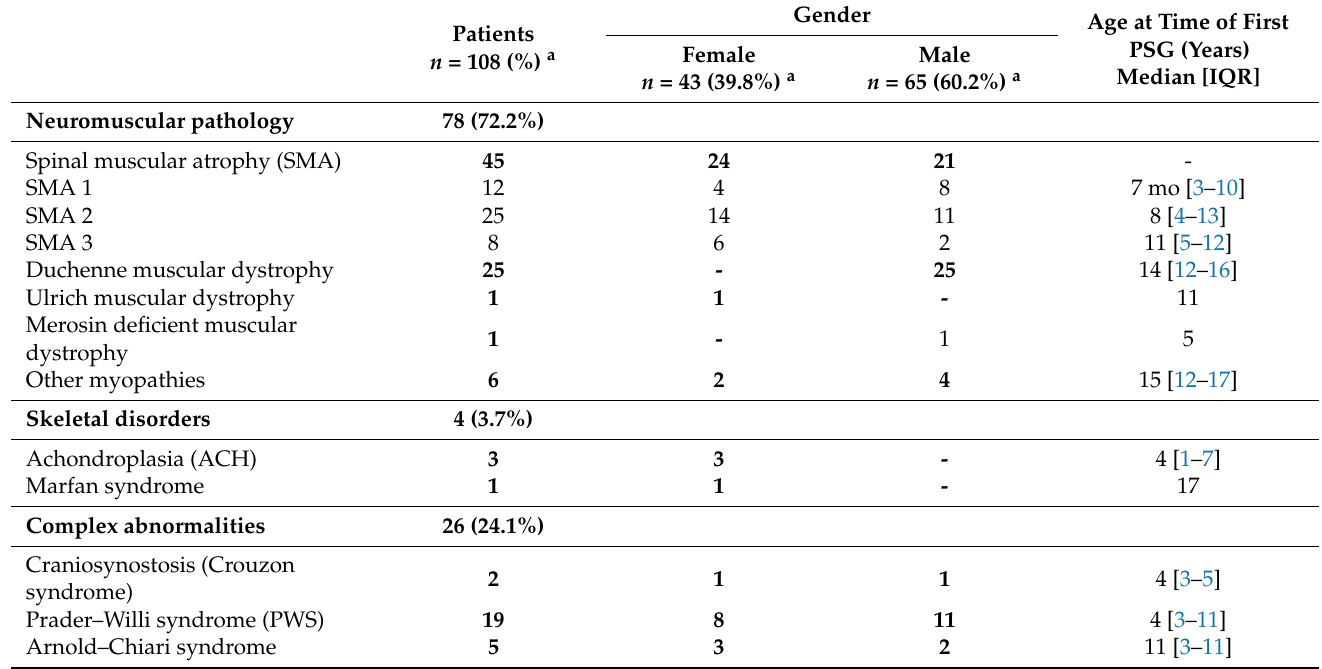
Table 1. Demographic and clinical characteristics of the study population.